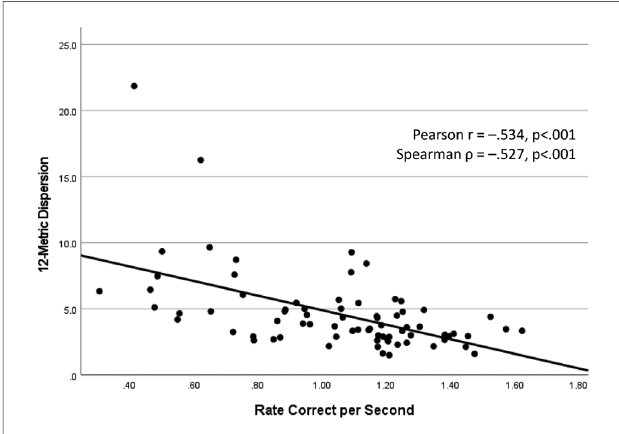
FIGURE 5 Prevalence of self-reported concussion within subgroups de fi ned by binary categorizations of 12-metric VR dispersion and SFWI.